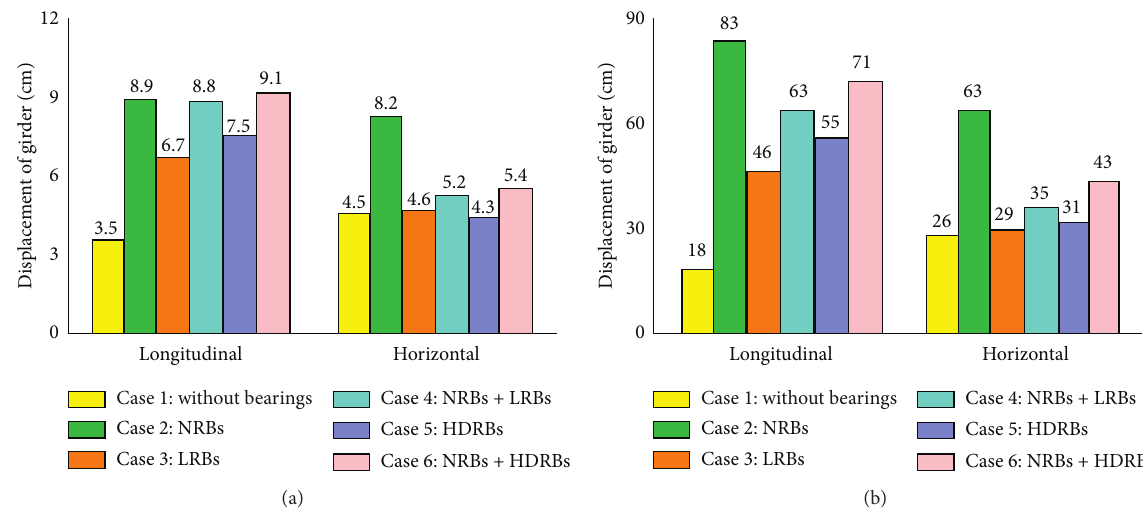
Figure 13: Displacement of the girder in different cases: (a) under the action of small earthquake; (b) under the action of large earthquake.